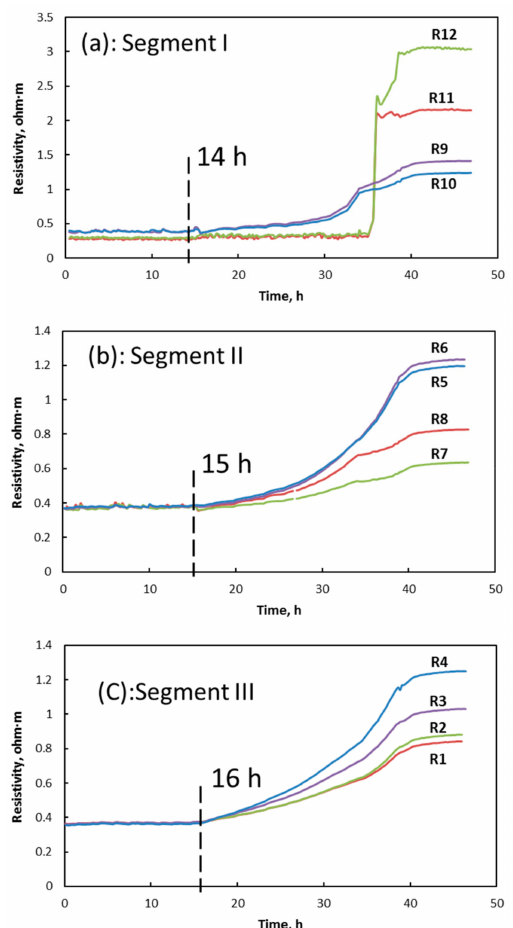
Figure 5. Electrical-resistivity evolution at di ff erent depths in sediments: Electrical resistivity distribution in ( a ) Segment I, ( b ) Segment II, and ( c ) Segment